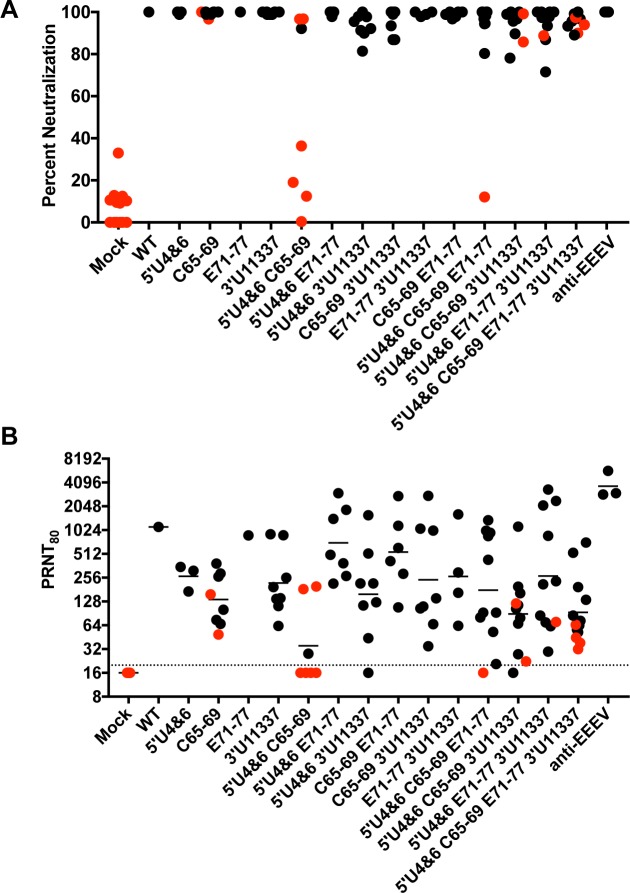
LAVs induce high levels of neutralizing antibodies that protect against aerosol challenge.Serum was collected on D21 post primary LAV infection and screened for neutralization antibody levels using a SINV-EEEV chimeric virus encoding the EEEV FL93 structural proteins. (A) Percent neutralization at 1:20 dilution of serum. (B) Reciprocal PRNT80 values for each mouse are graphed. Each black circle indicates a single mouse that survived aerosol challenge. Each red circle indicates a mouse that died after aerosol challenge. The black line represents geometric mean PRNT80 value and the dotted line indicates limit of detection of the assay.